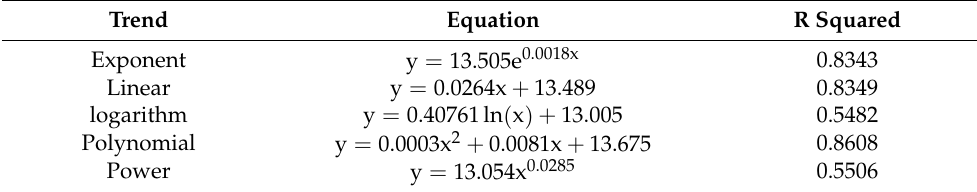
Table 8. Equations of variation trends for global mean temperature from 1961 to 2019. Trend Equation R Squared Exponent y = 13.505e 0.0018x